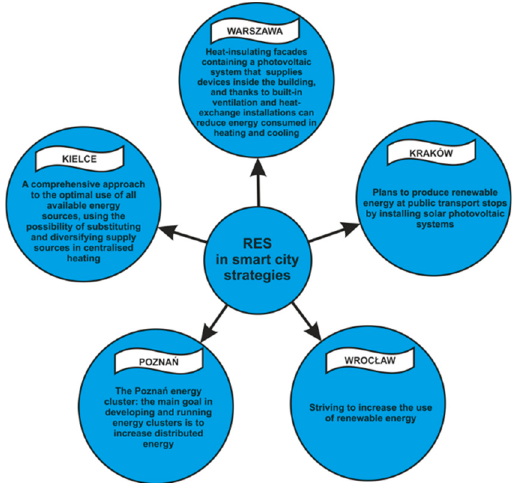
Figure 6. RSE in smart city strategies. Source: own study based on smart city strategies [137–141].